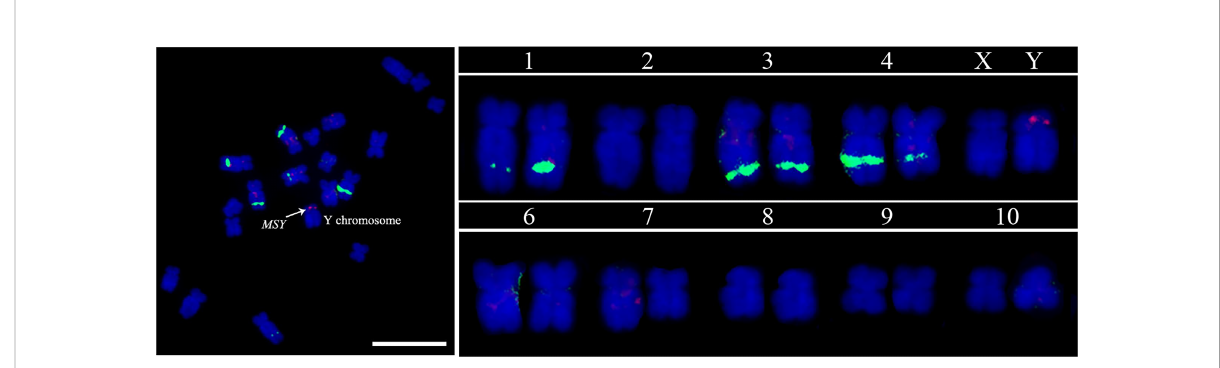
FIGURE 5 MSY identi fi cation based on FISH analysis using fi ve MSY-speci fi c single copy sequence probe cocktails. The red signal denotes the MSY, and the green signals indicate the 45S rDNA. Scale bar = 10 m